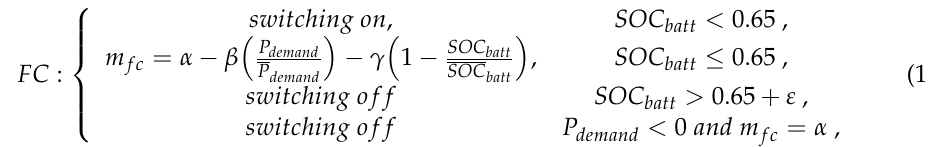
Figure 9. Results of the designed energy management control strategy for the NEDC cycle: ( a ) when the initial SOC is 0.4; ( b ) when the initial SOC is 0.55; ( c ) when the initial SOC is 0.7.